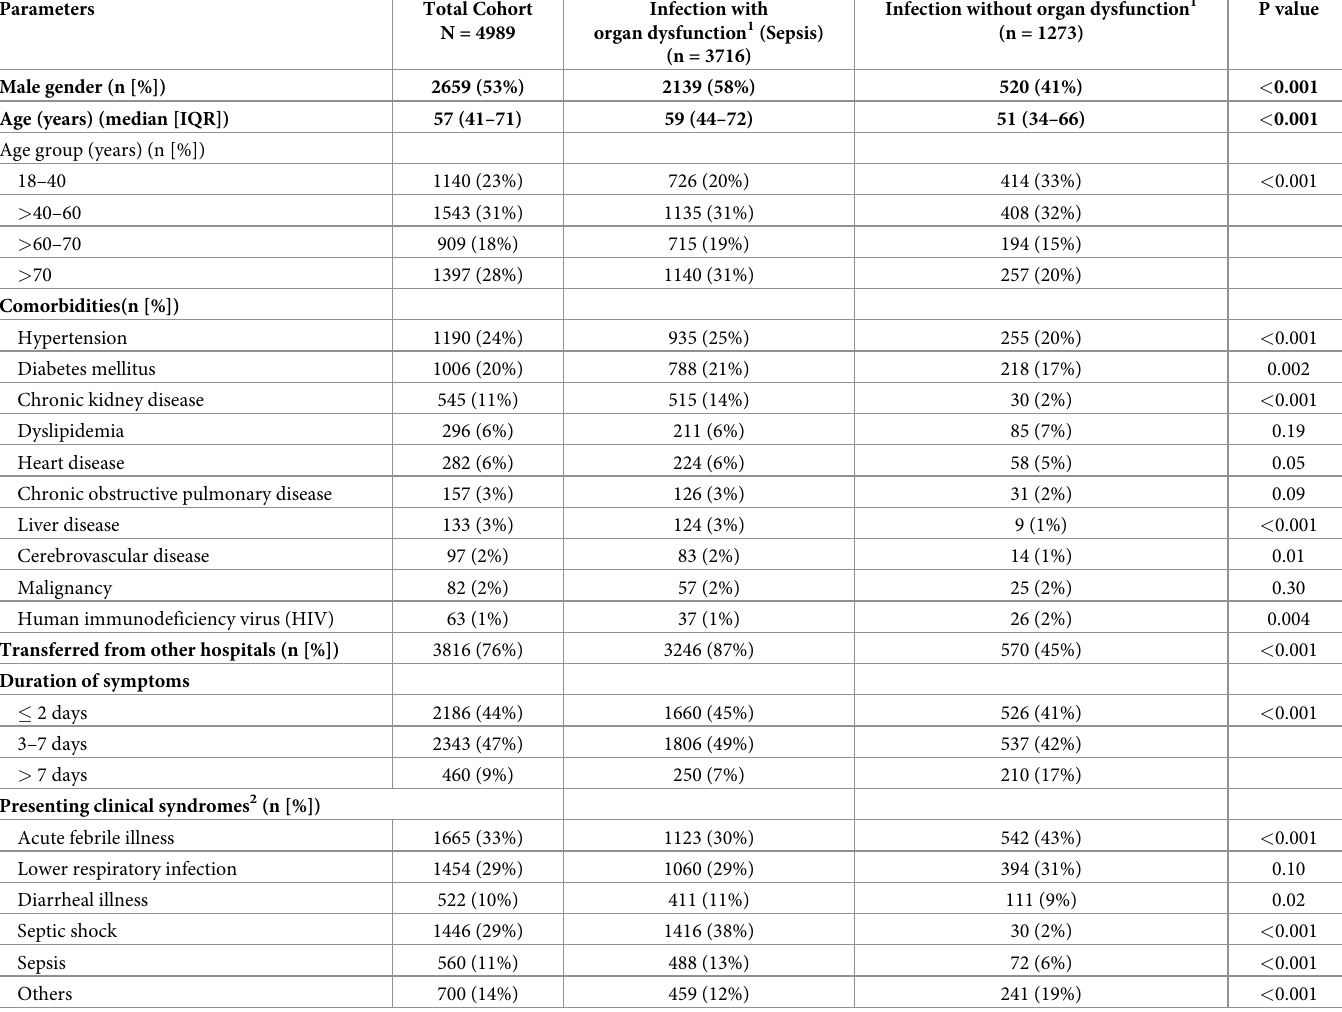
Table 1. Baseline characteristics of infected patients with and without organ dysfunction within 24 hours of